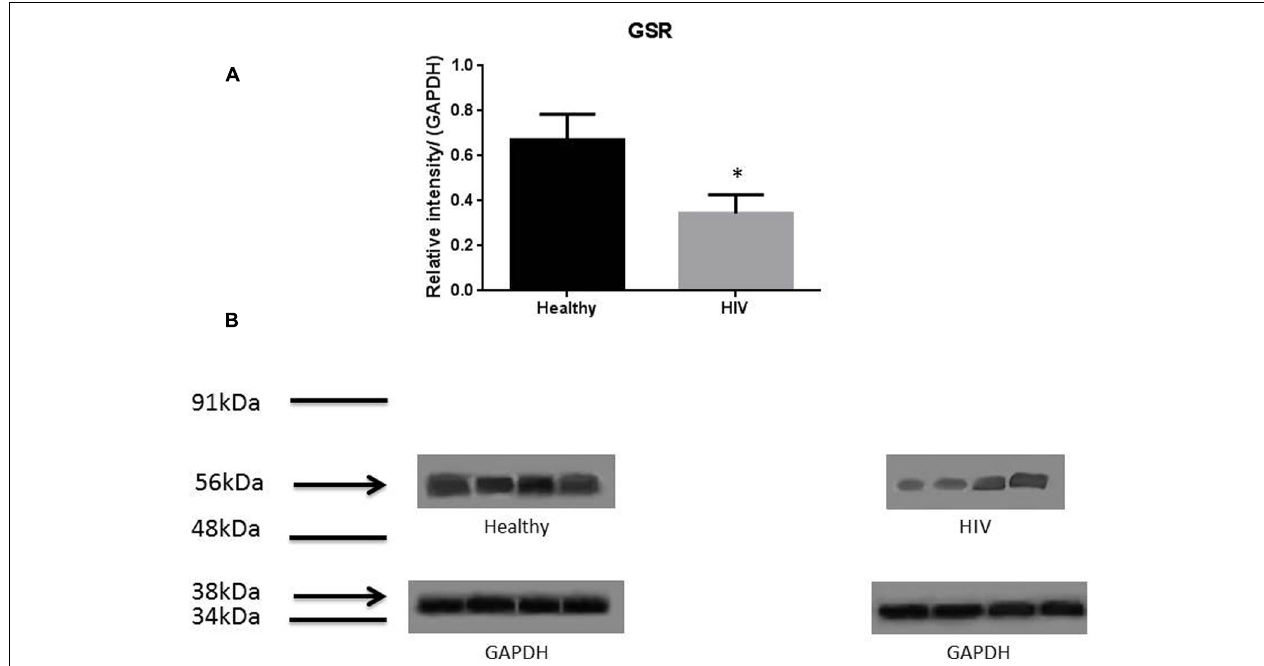
used. GSR levels in HIV-infected individuals are lower compared to healthy. Data in (A) represents significant difference in the levels of GSR between RBC isolated from five healthy individuals and five individuals with HIV infection (* p ≤ 0.05). (B) : Illustrates representative images of GSR and their corresponding GAPDH bands from four healthy subjects and four individuals with HIV infection.